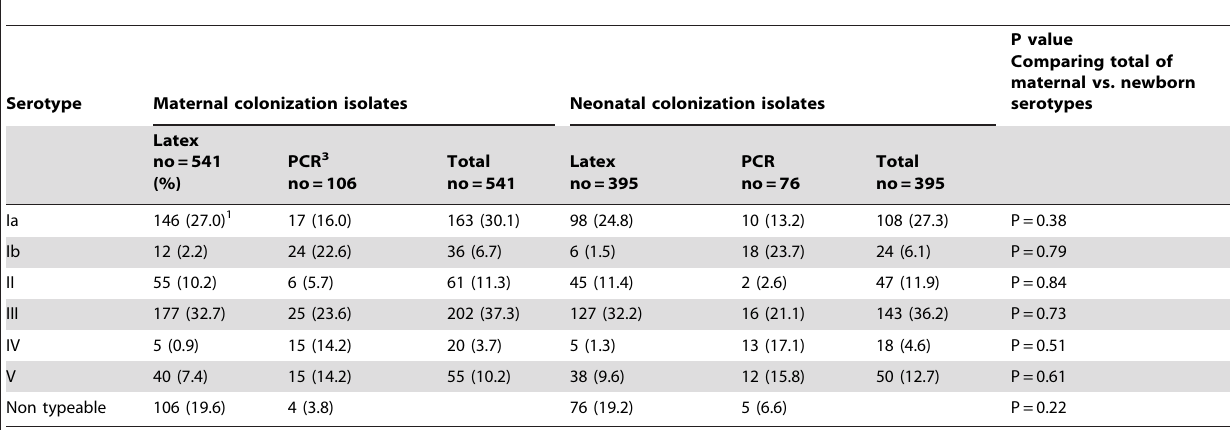
Table 1. Serotype distribution among maternal and newborn colonizing Group B streptococcus isolates.